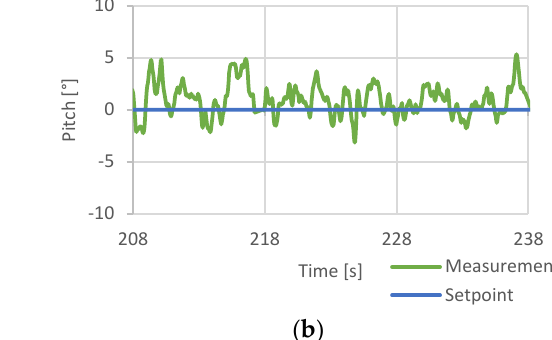
Table 3. Final control loop settings.